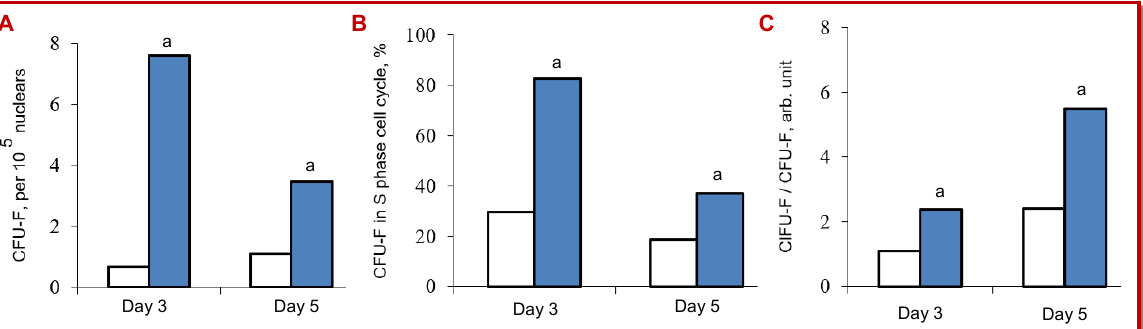
Figure 2: Effects of the PKA inhibitor on the number of CFU-F in wound surface (A), proliferative activity (B), and these cells dif- ferentiation index (C) in control C57BL/6 mice (white bars) and the treatment of the wound with the PKA inhibitor (blue bars). a p<0.05 in comparison with the control